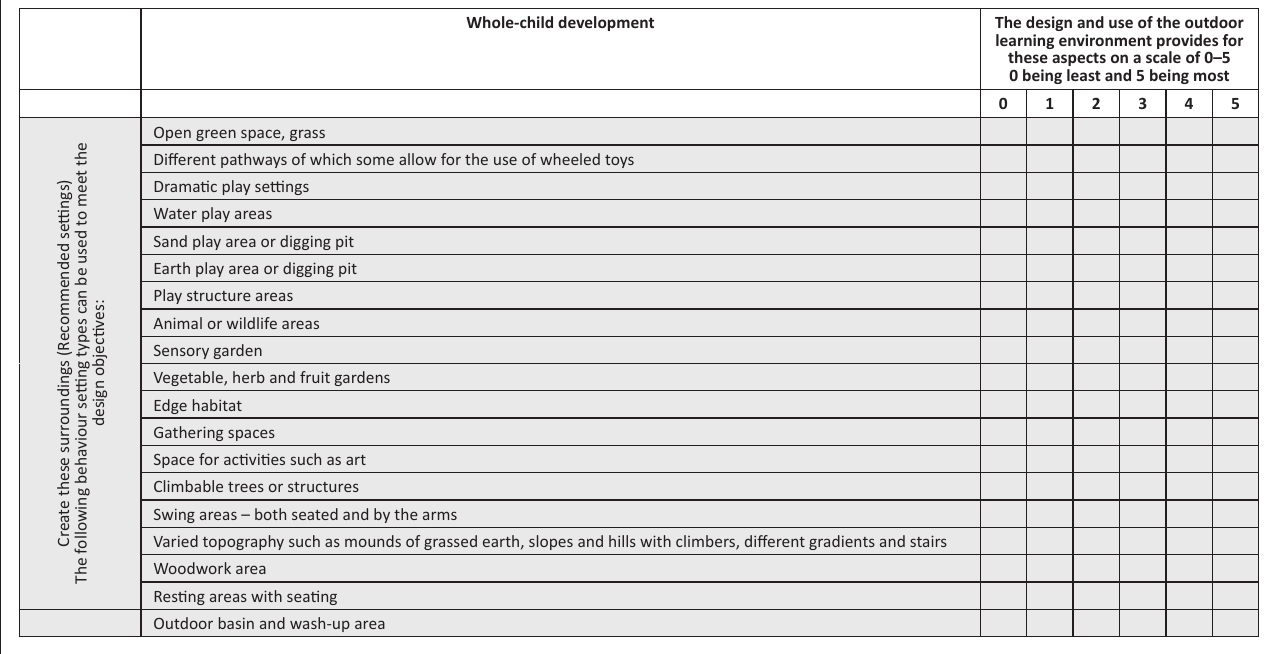
FIGURE 1 (Continues...): Checklist for the design and use of an outdoor learning environment for sensory and motor development as part of the whole child